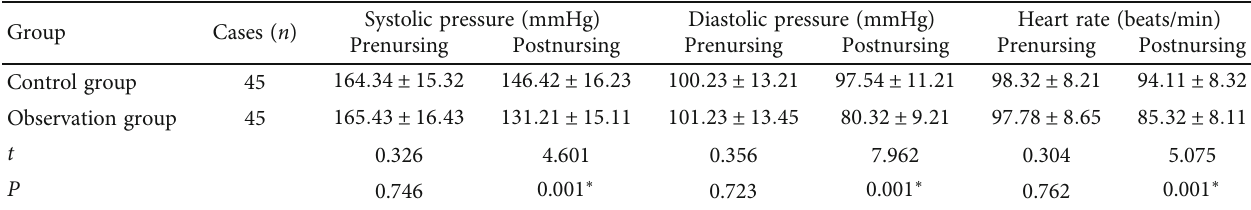
Table 2: Comparison of blood pressure and heart rate levels before and after care in 2 groups ( (cid:1) x ± s ). Group